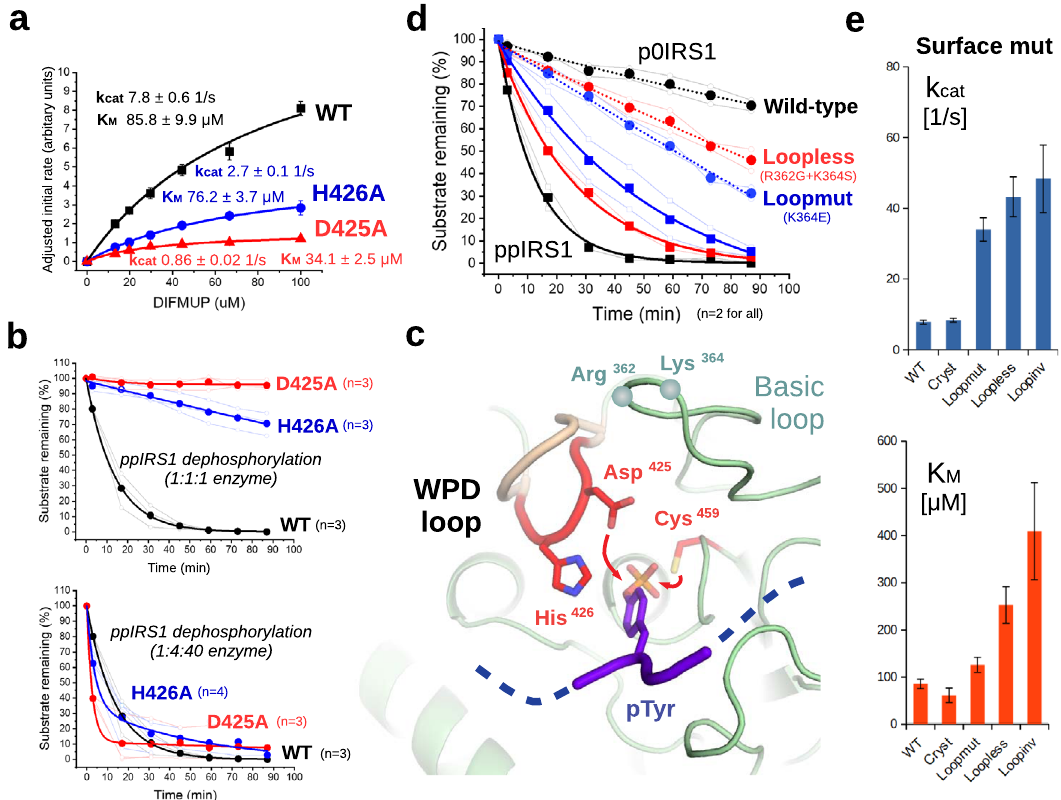
Fig. 7 | Validation of SHP2 catalytic apparatus. a Kinetic experiments ( n =3 technical repeats, mean and ±SD plotted for each point) with the small-molecule substrate DIFMUP indicate that mutation of either Asp425 (required for nucleo- philicattackonthephosphocysteineintermediate)orHis426(requiredforoptimal positioning of the pTyr) impairs catalytic activity of SHP2, with a more-or-less pronounced effect on k cat . b Capillary electrophoresis (CE)-based kinetic assays with the ppIRS1 substrate peptide display slowed reaction rates mirroring those seenwithDIFMUP.Withtheenzymequantitiessetto1:4:40thedephosphorylation rates became more similar. Thin lines and small points show individual experi- ments, the thick lines are exponential curves fi tted over their means (large dots). c ModelofthecatalyticstateofSHP2,illustratingtheclosureoftheWPDloop with key residues involved in catalysis (D425, H426, C459) or controlling the formation of the closed catalytic state (R362, K364). d CE-based dephosphorylation assays